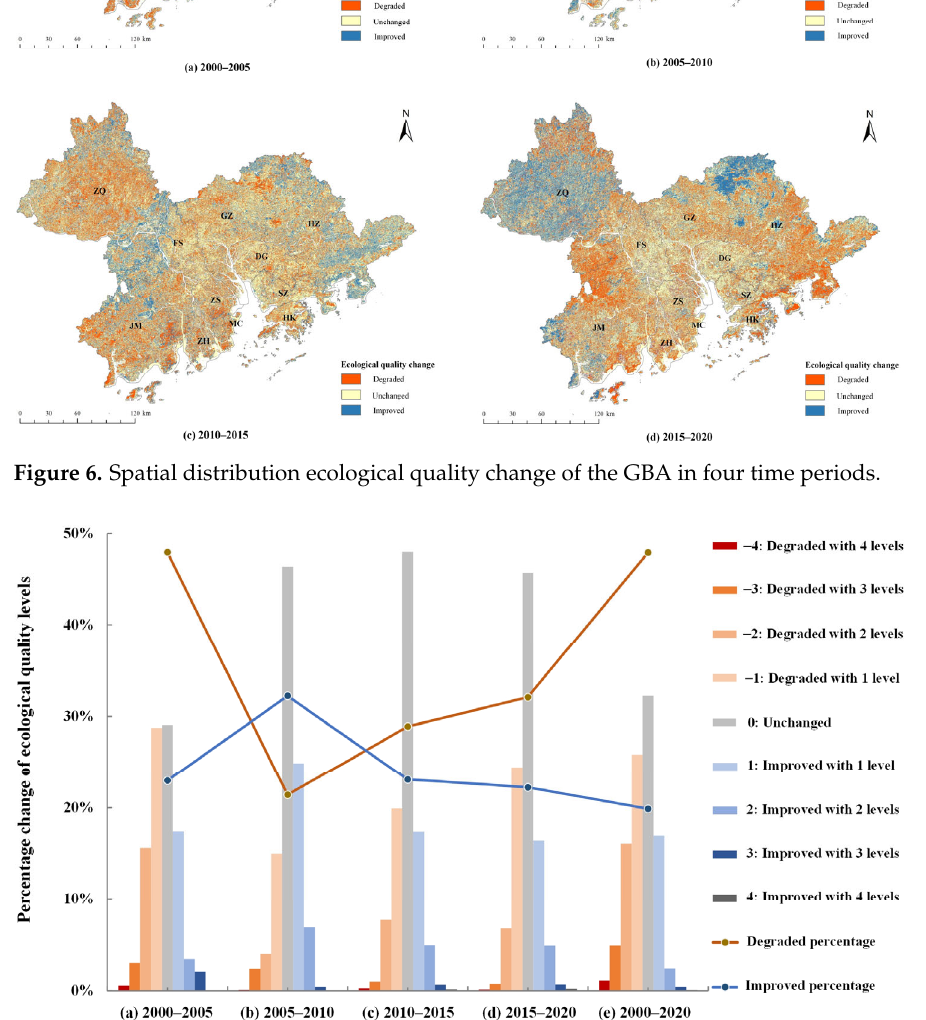
Figure 7. Percentage changes of ecological quality levels of the GBA from 2000 to 2020.